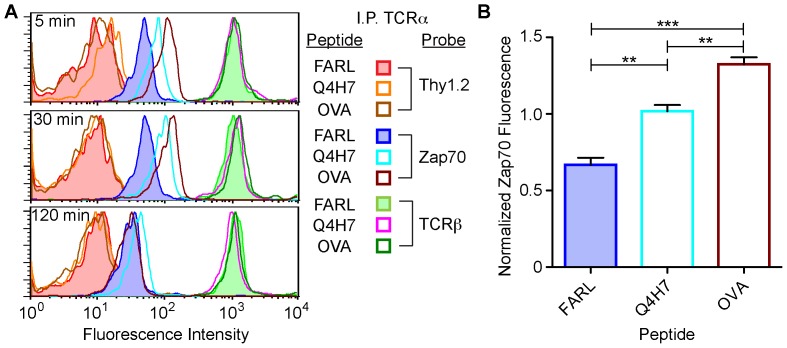
IP-FCM detects antigen-induced transient increase in ZAP70 association with TCR/CD3.OT1 TCR transgenic T cells were co-incubated with peptide-loaded T2Kb APCs for up to two hours. The APCs had been pulsed with either FARL or OVA peptides presented in H-2Kb. Following stimulation, cells were lysed and subjected to IP-FCM analysis. (A) ZAP70 association with TCR/CD3 increased in OVA- and Q4H7-stimulated cells (OVA: dark brown, open histogram; Q4H7: aqua, open histogram), when compared with FARL (blue, filled histograms). This difference was maintained by 30 minutes, but disappeared by 120 minutes. (B) For the ZAP70 recruitment data in each of 3 independent experiments, normalized values were calculated as described in Materials and Methods in order to assess the difference in fluorescence of each experimental group from the mean (set to 1) of all three experimental groups. This normalization manipulation allowed the data from the 3 independent experiments to be considered on a single scale while subjected together to one-way ANOVA followed by Newman-Keuls post-hoc tests. A significant difference was observed between OVA and FARL, OVA and Q4H7, and Q4H7 and FARL-induced ZAP70 association with TCR/CD3 (ANOVA: F2,9 = 55.8, p<0.0001; **p<0.01, ***p<0.005).